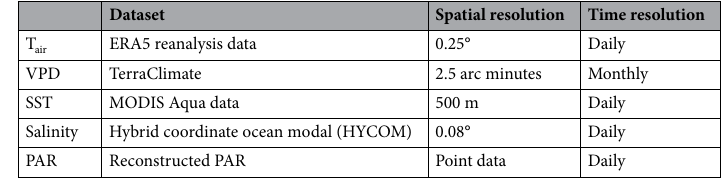
Table 2. Summary of the climatic